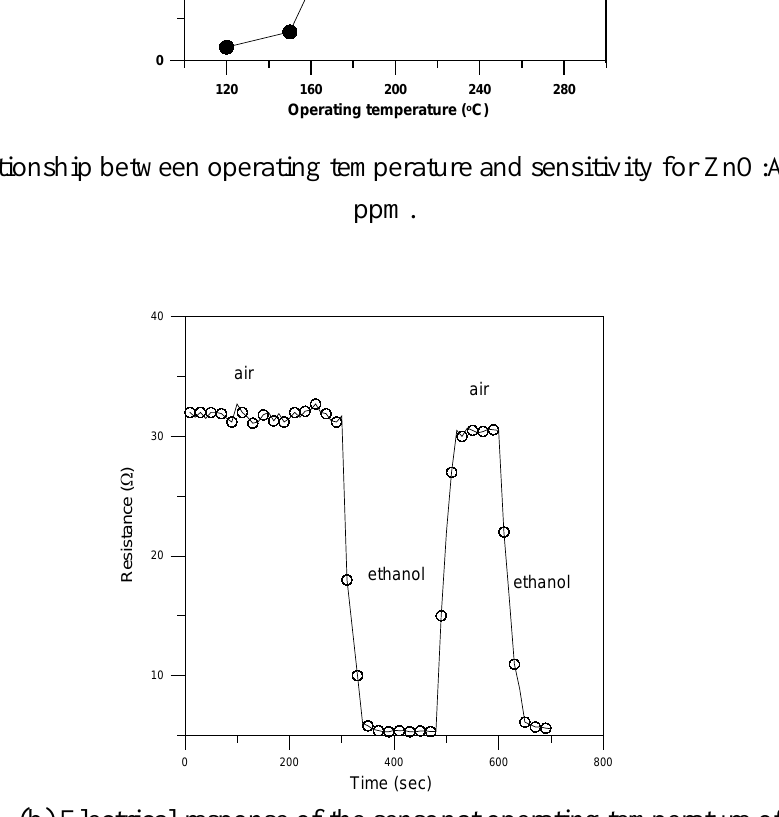
Figure 4. (b) Electrical response of the sensor at operating temperature of